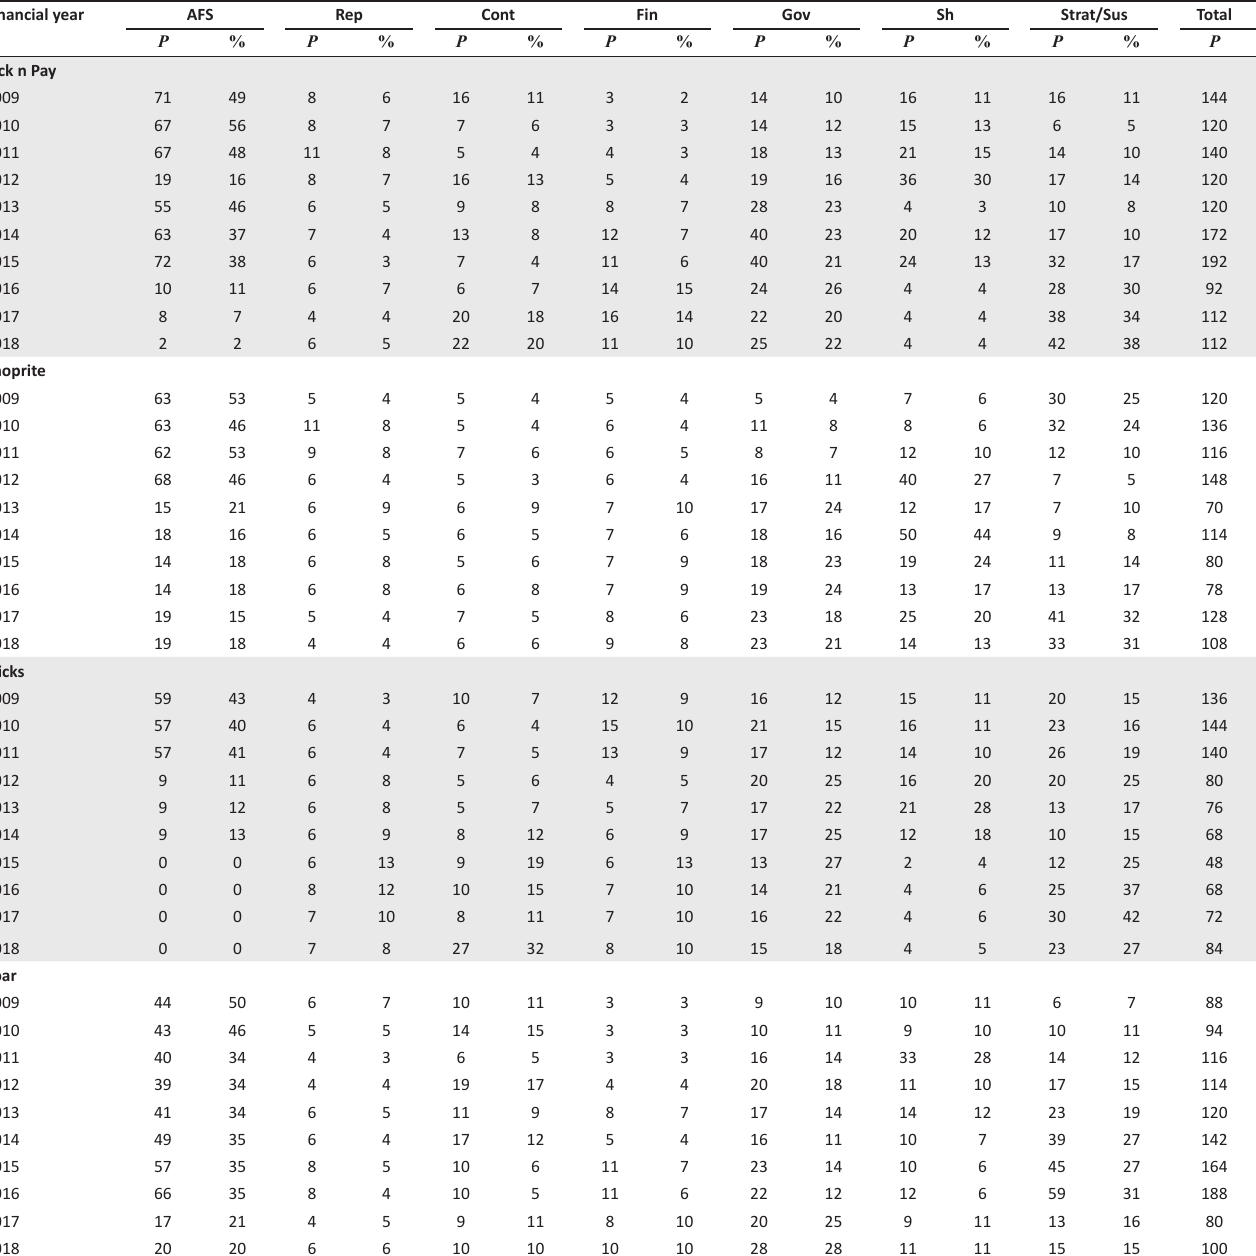
TABLE 3: Annual integrated report composition: Pick n Pay, Shoprite, Spar and Clicks. Financial